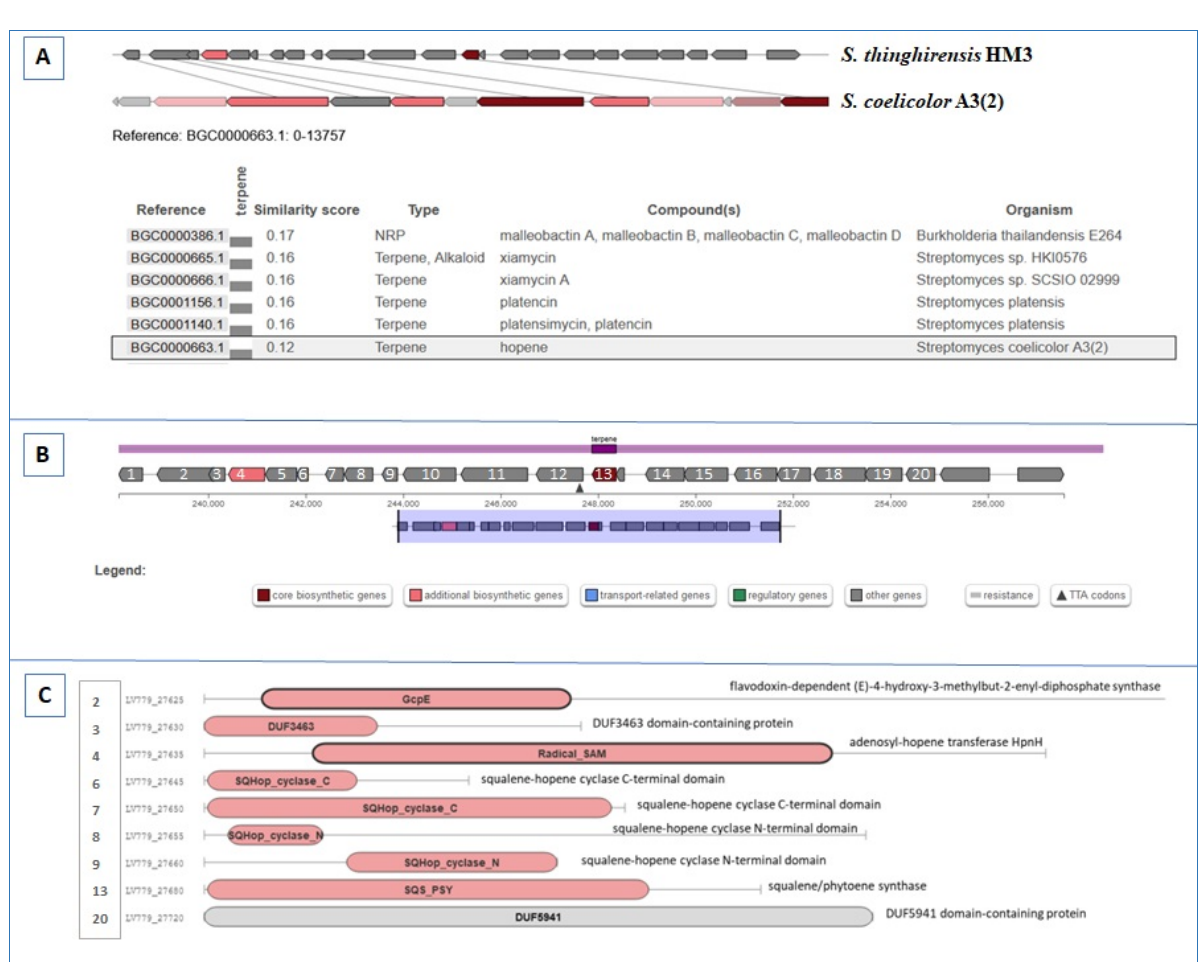
Figure 4. Terpene (hopene) biosynthetic gene cluster in S. thinghirensis HM3. ( A ) The comparison between the proposed hopene gene cluster (dark red gene) in strain HM3 and the proposed identified cluster of hopene in S. coelicolor A3(2) with a similarity score of 0.12 on the MIBiG website. ( B ) The proposed hopene gene cluster in region 50.2 from strain HM3 genome contains; 1, 1-deoxy-D-xylulose-5-phosphate synthase; 5, 1-hydroxy-2-methyl-2-butenyl 4-diphosphate reductase; 10, polyprenyl synthetase; 11, hydroxysqualenedehydroxylaseHpnE; 12, squalene/phytoene synthase; 14, ABC transporter ATP-binding protein; 15, ABC transporter permease; 16, glycosyltransferase; 17, CDP-alcohol phosphatidyltransferase; 18, iron-containing alcohol dehydrogenase; 19, phosphocholine cytidylyltransferase. ( C ) represents the predicted genes involved in hopene biosynthesis based on the Pfam website.